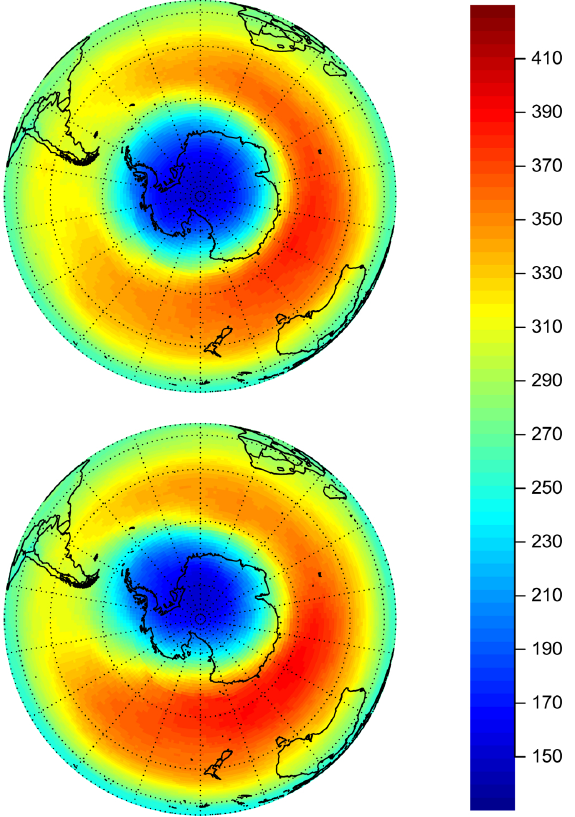
Fig. 7. Southern Hemisphere October mean column ozone (in DU) in 1989–1992. Top: 1989–1990 for pre-Pinatubo eruption period. Bottom: 1991–1992 for the eruption period.